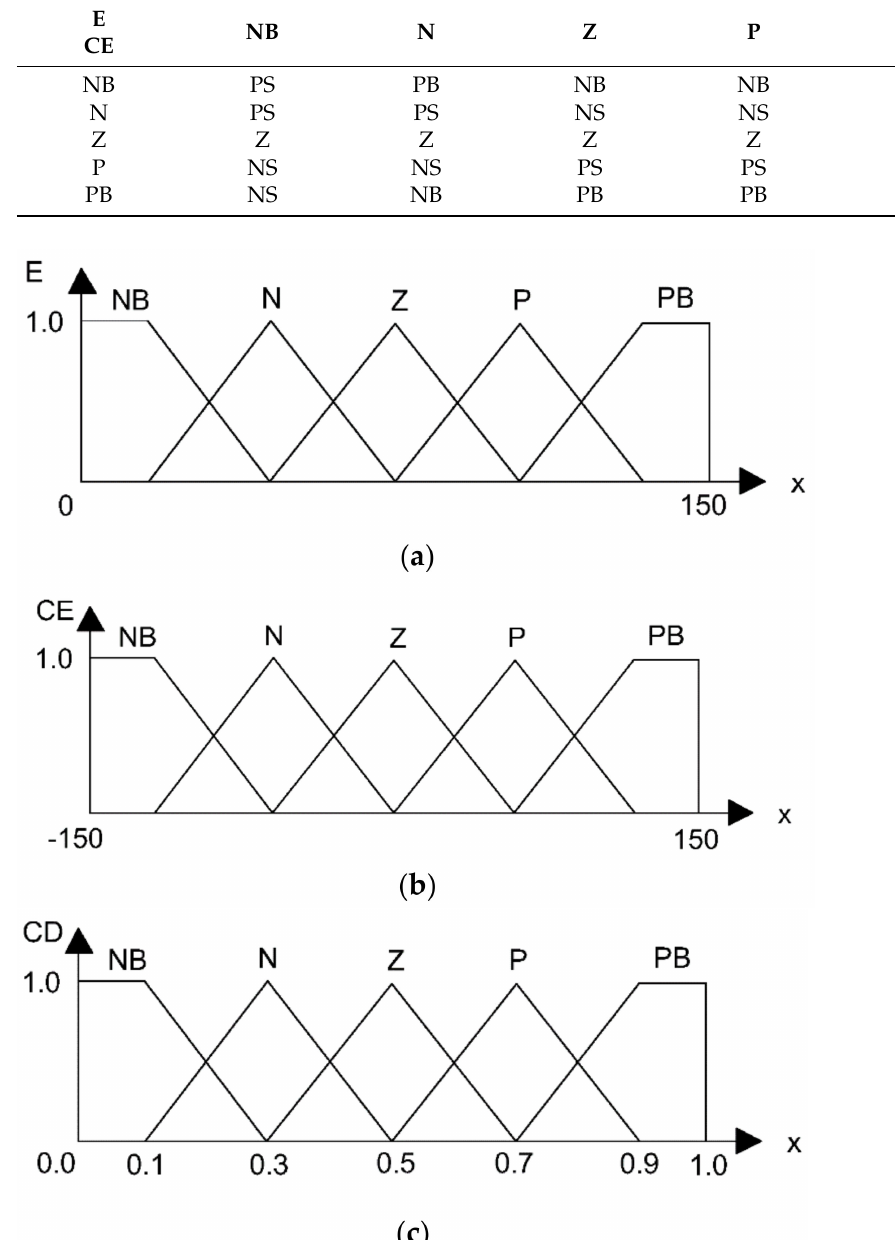
Figure 9. Membership functions of the fuzzy system. ( a ) Error signal. ( b ) Change of error signal. ( c ) Change of duty